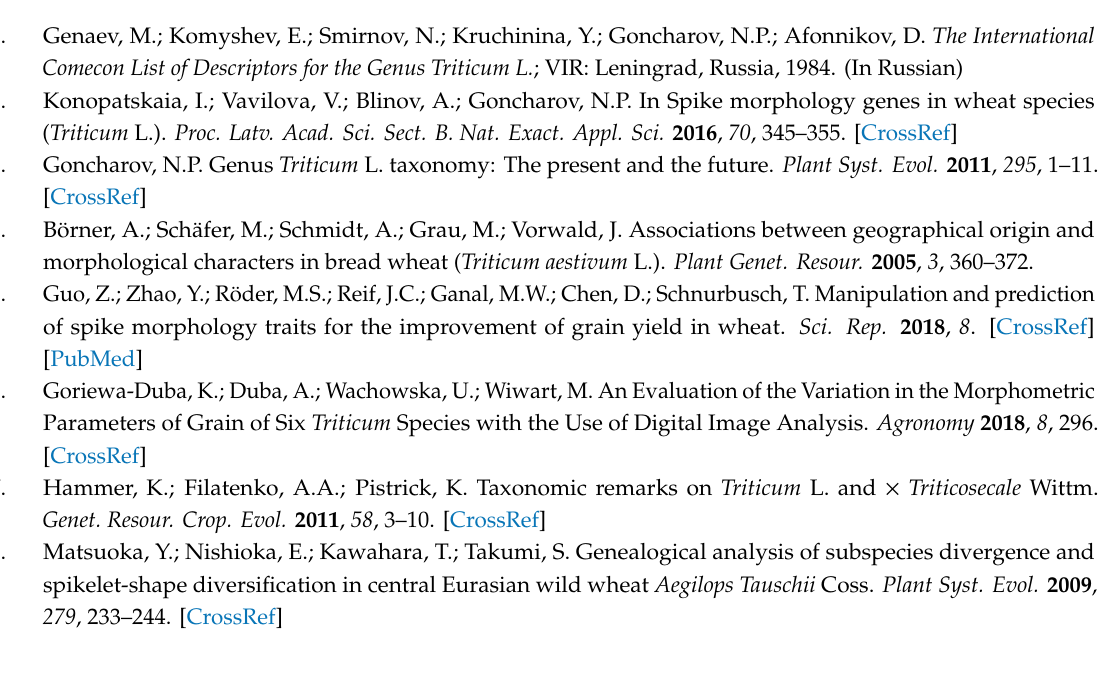
Figure S10. Scatterplot diagram for the main spike length for Triple Dirk B × KU506 F 2 hybrid plants estimated manually and from the 2D image